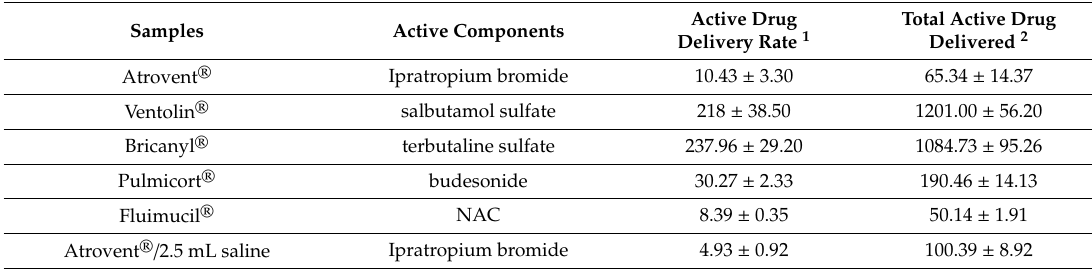
Table 5. Active drug delivery rate and total active drug delivered of test samples.